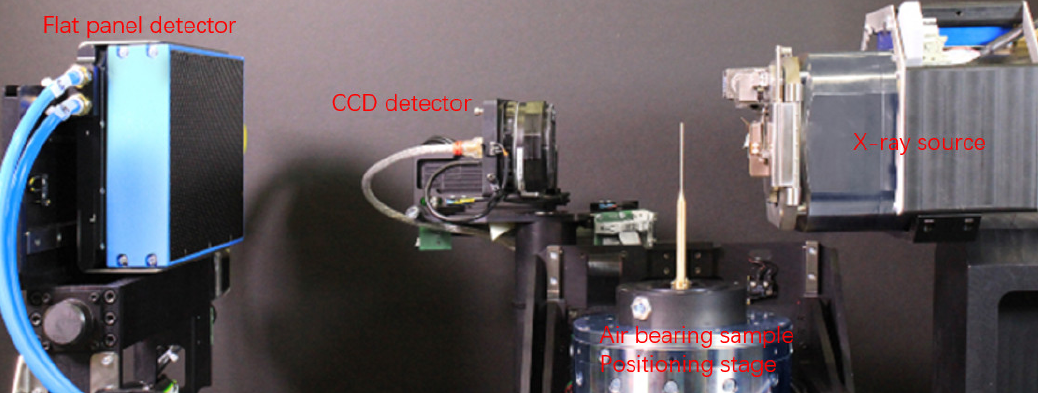
Figure 2. CT scanning equipment adopted.